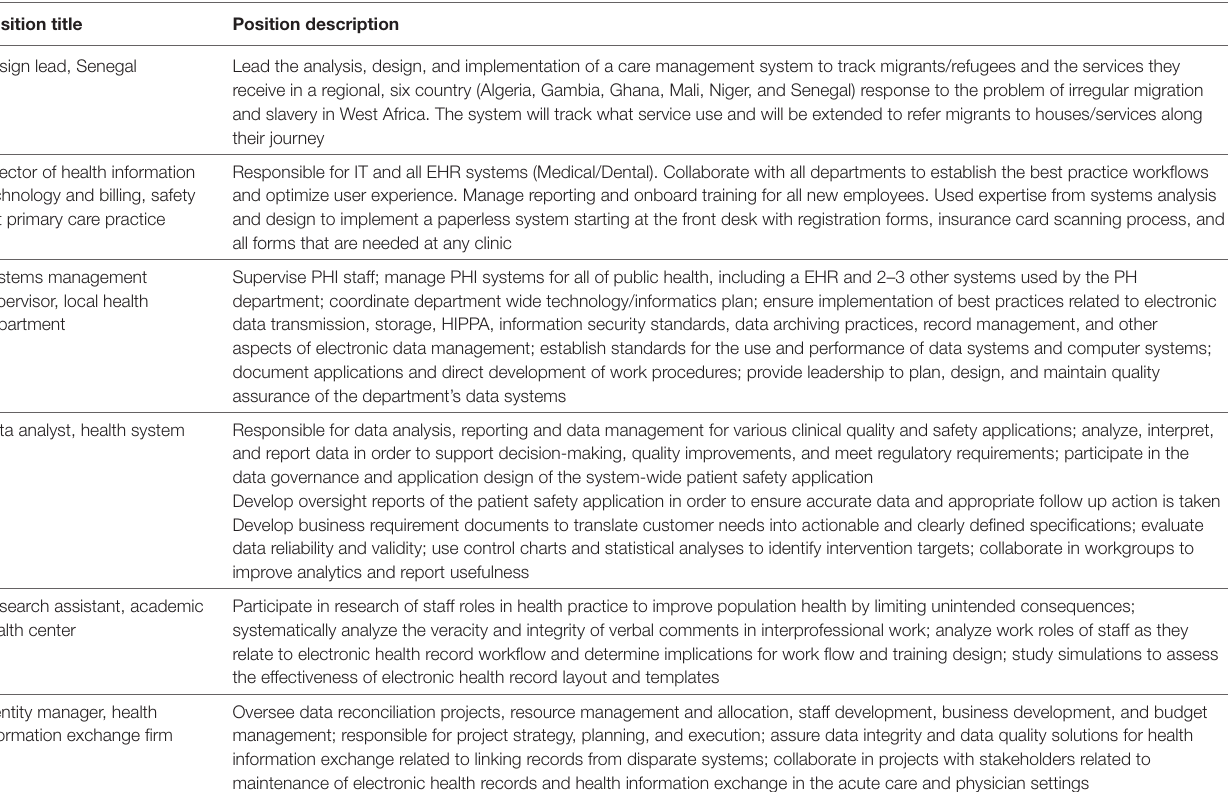
taBle 5 | Recent master’s in public health public health informatics graduates position